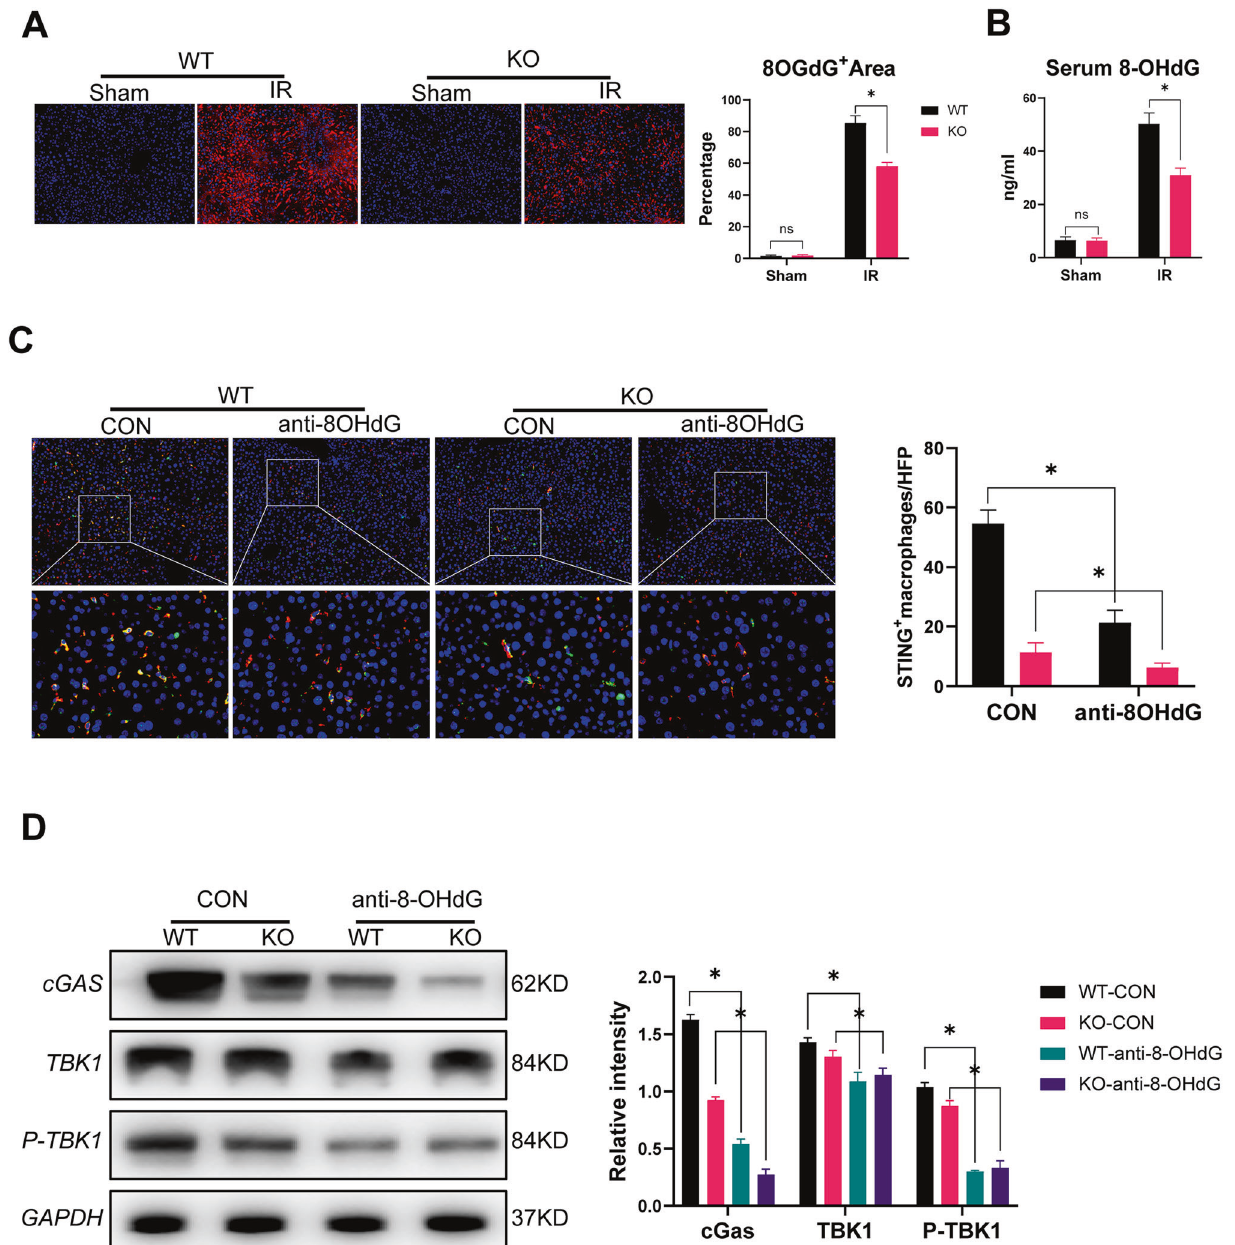
Fig. 3 MLKL de fi ciency inhibited macrophage STING activation by reducing hepatocyte oxidative DNA damage. WT and MLKL KO mice were subjected to liver IR model or sham procedure. Liver tissues, blood samples and intrahepatic macrophages were collected at 6 h post reperfusion. A Immuno fl uorescence staining of DAPI (blue), 8-OHdG (red) in livers. B Serum levels of 8-OHdG. Mice were pretreated with anti- 8-OHdG antibody (10 mg/kg) at 3 h prior to ischemia and sacri fi ced at 6 h post reperfusion. C Immuno fl uorescence staining of DAPI (blue), F4/ 80 (red) and STING (green) in livers. D Western blot analysis of cGAS, TBK1, P-TBK1, and GAPDH in isolated macrophages. n = 5 mice/group. All results represent at least two independent experiments. Values were expressed as mean ± SD. * p <